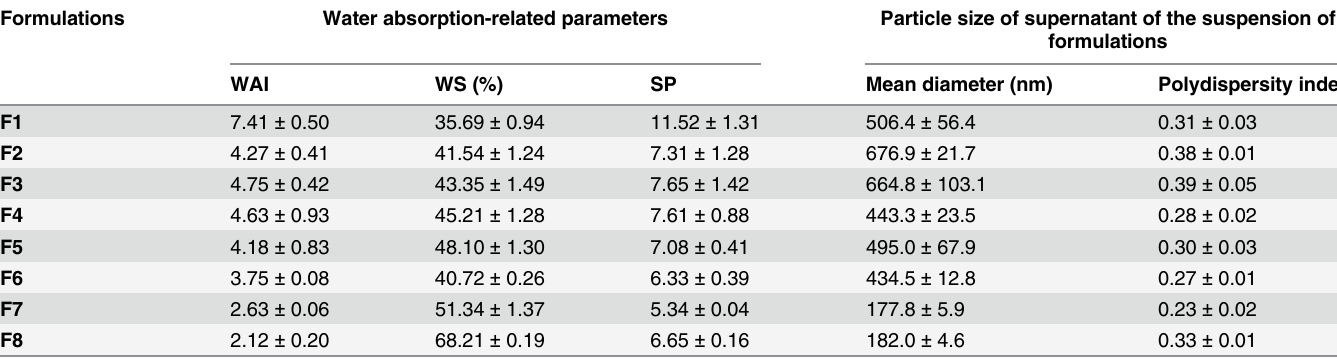
Table 5. Water absorption-related parameters and particle size analysis of supernatant of the suspension of AGN formulations.